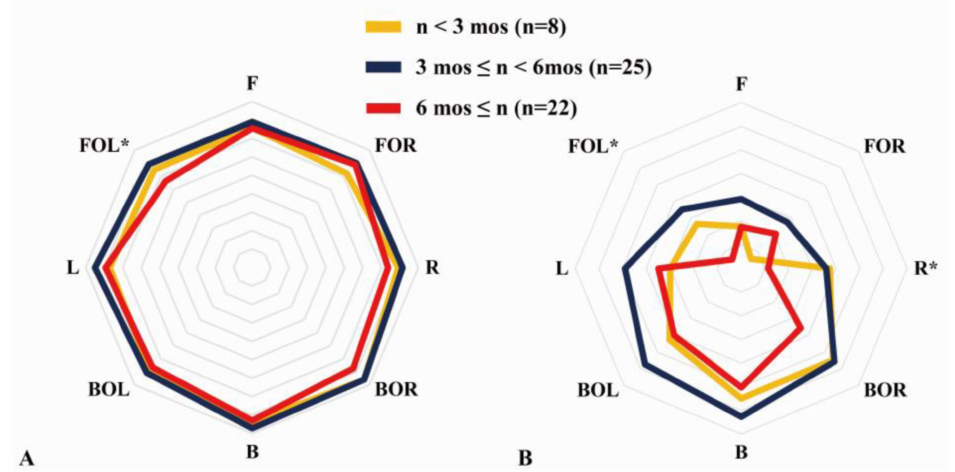
Figure 8. Subanalysis of the core muscle asymmetry according to postoperative day. ( A ) Direction core muscle ratio (DCMR). ( B ) Core muscle state ratio (CMSR). One-way analysis of variance. * Significant difference between the group ( p < 0.05). mos: